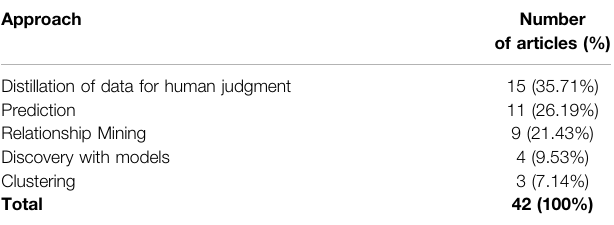
TABLE 8 | Main data analysis approaches used studies on learning analytics in high schools.